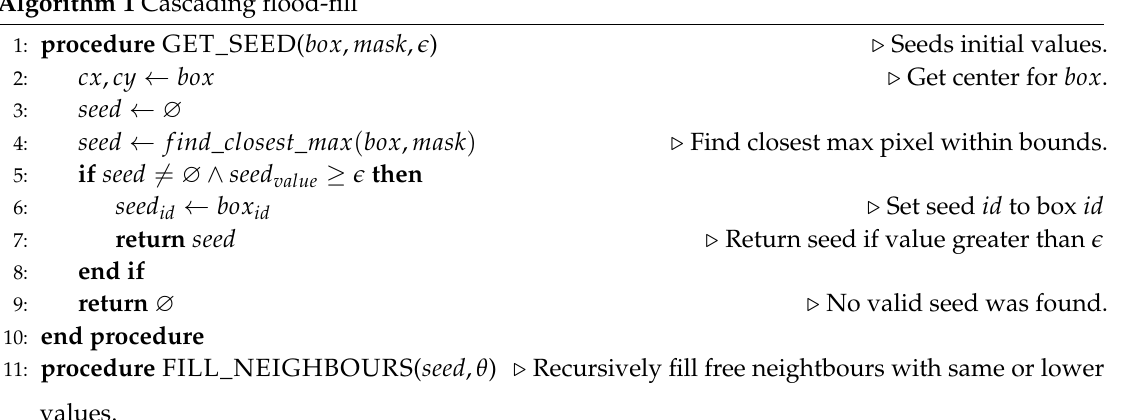
Algorithm 1 Cascading